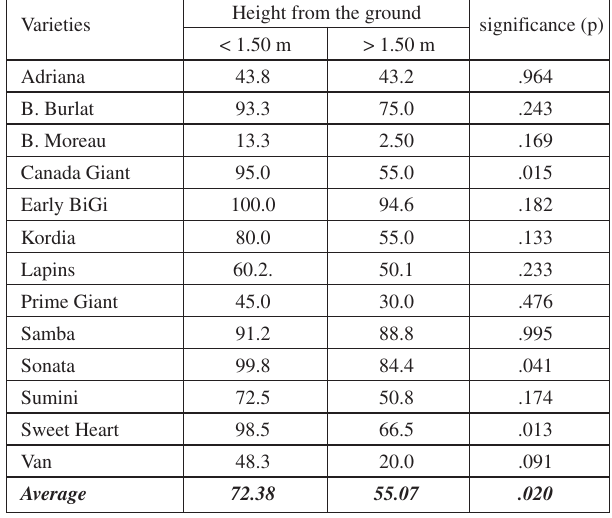
Table 7. Average of flowers percentage destroyed by spring frost, in orchard 3 as related to their phonological